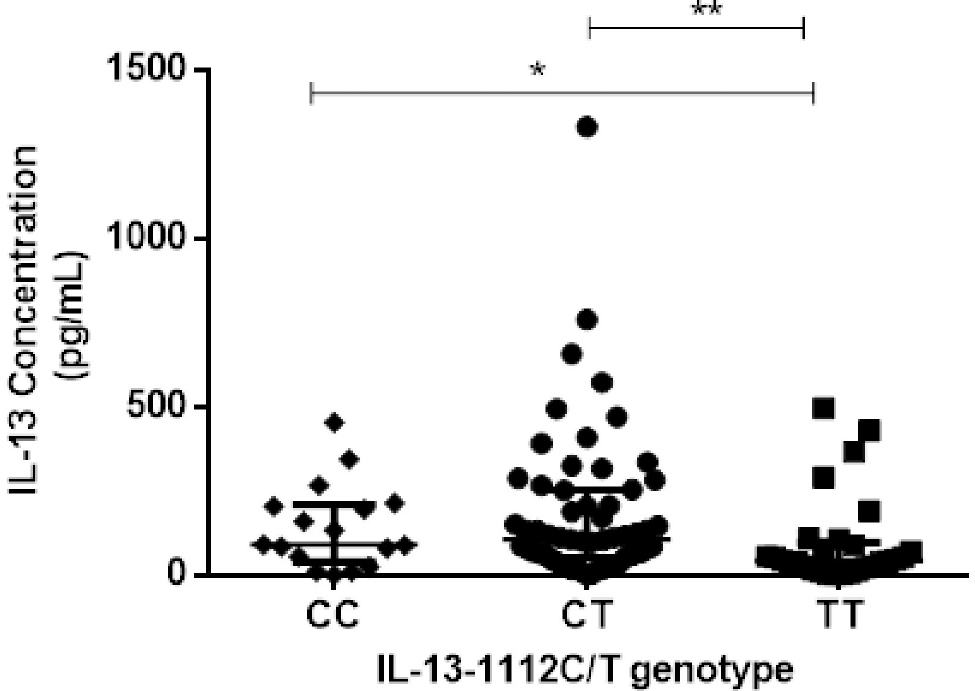
Fig 3. Comparison of IL-13 cytokine levels in IL-13–1112 C/T variants.